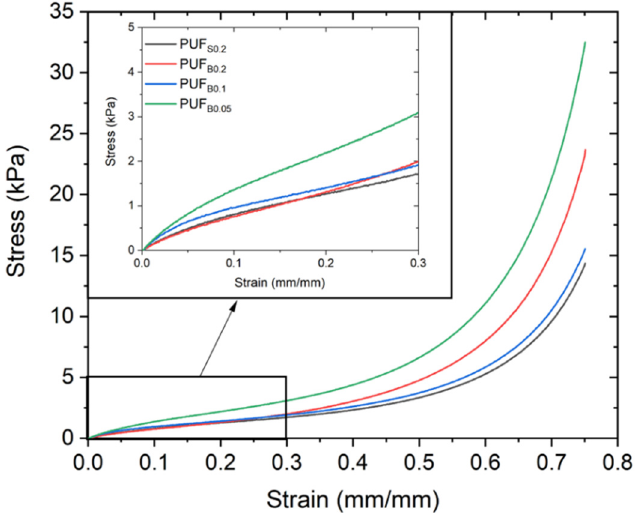
Figure 6. Average stress-strain curves of PUF prepared with bismuth triflate and stannous octoate.